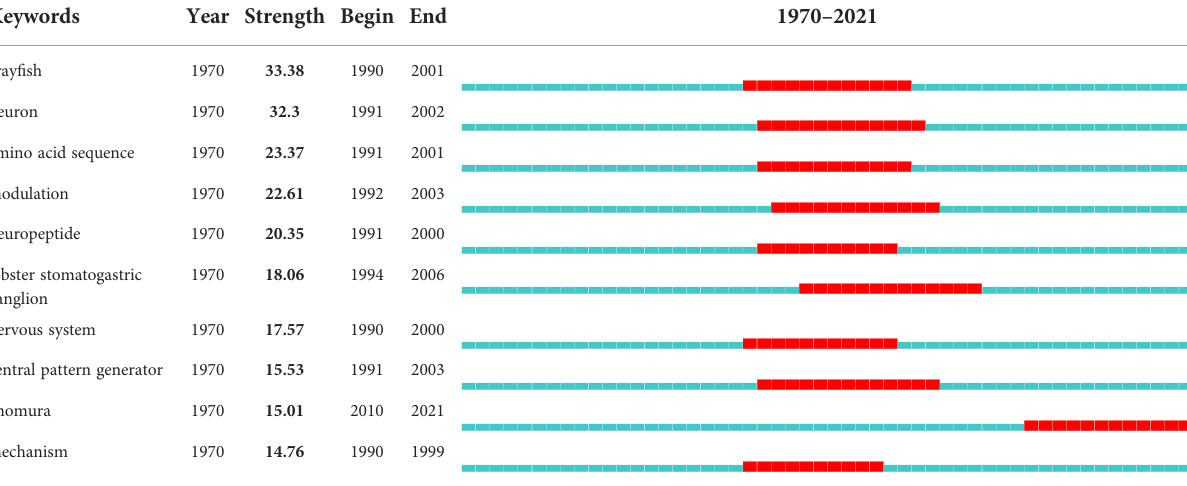
TABLE 6 Top 10 keywords with the strongest citation burst in marine lobster research published between 1970 and 2021